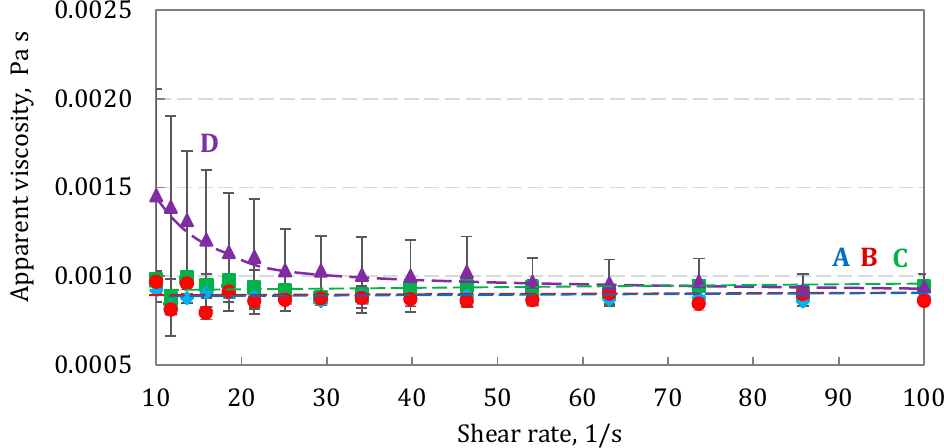
Figure 8. Apparent dynamic viscosity as a function of shear rate for BUD suspensions A, B, C, and D (25 ± 0.5 ° C). Error bars show the standard deviation ( n = 3). Lines are drawn to guide the eye.